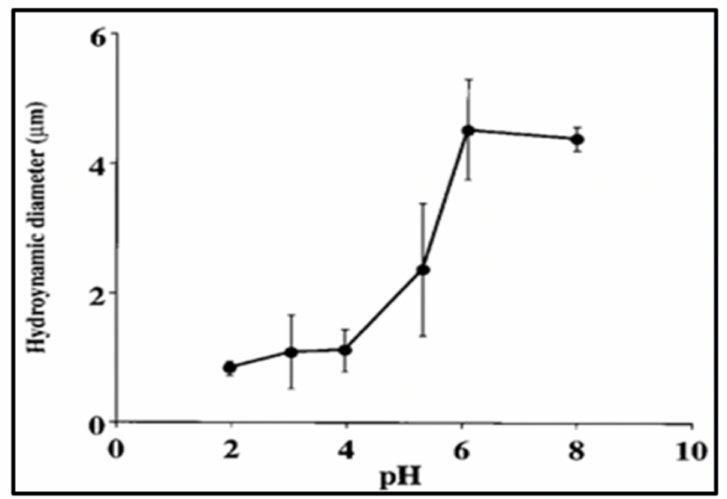
Figure 20. pH-induced phase transition of MG. Notice that this transition occurs within the same range as the expected pKa (4.5–5) of carboxylic groups of DOM. Each point corresponds to the average ± SD of five